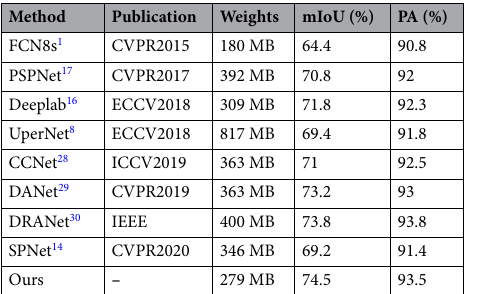
Table 2. Performance comparison of different models in PASCAL VOC 2012 (val).